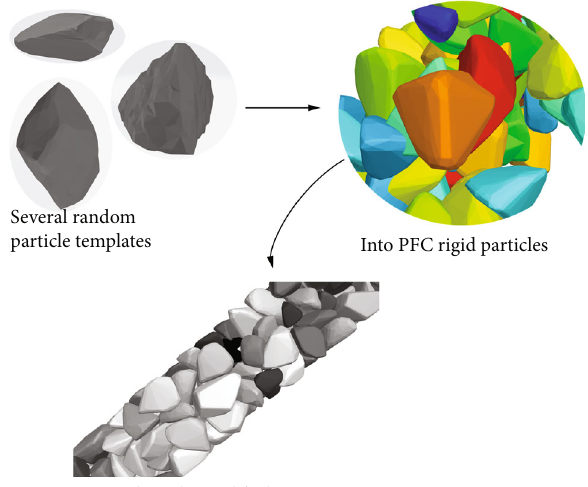
Figure 3: Simulation of the fault fracture